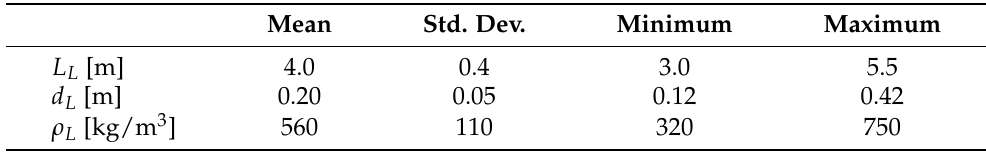
Table 1. Mean, standard deviation, and extreme values of log length L L , log diameter d L , and log density ρ L of all tested logs ( n = 55).